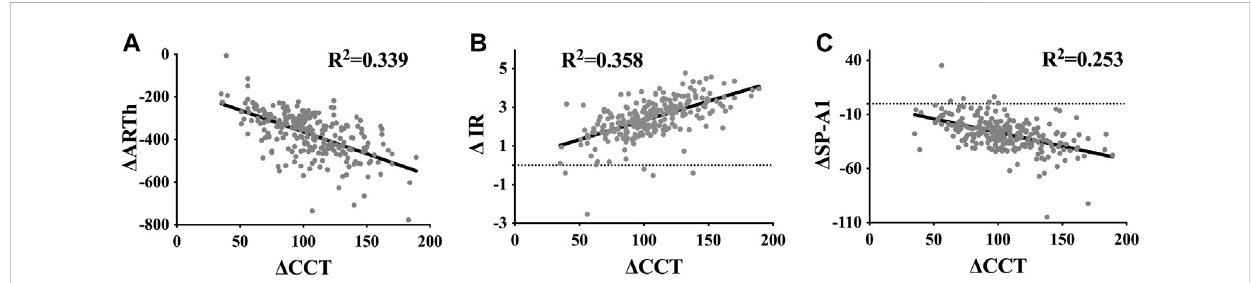
FIGURE 3 Scatter diagram and linear fi t for thedifferences indynamic corneal response parameters, including ARTh (A) , IR (B) , and SP-A1 (C) , recordedbefore and after small incision lenticule extraction, and the corresponding changes in central corneal